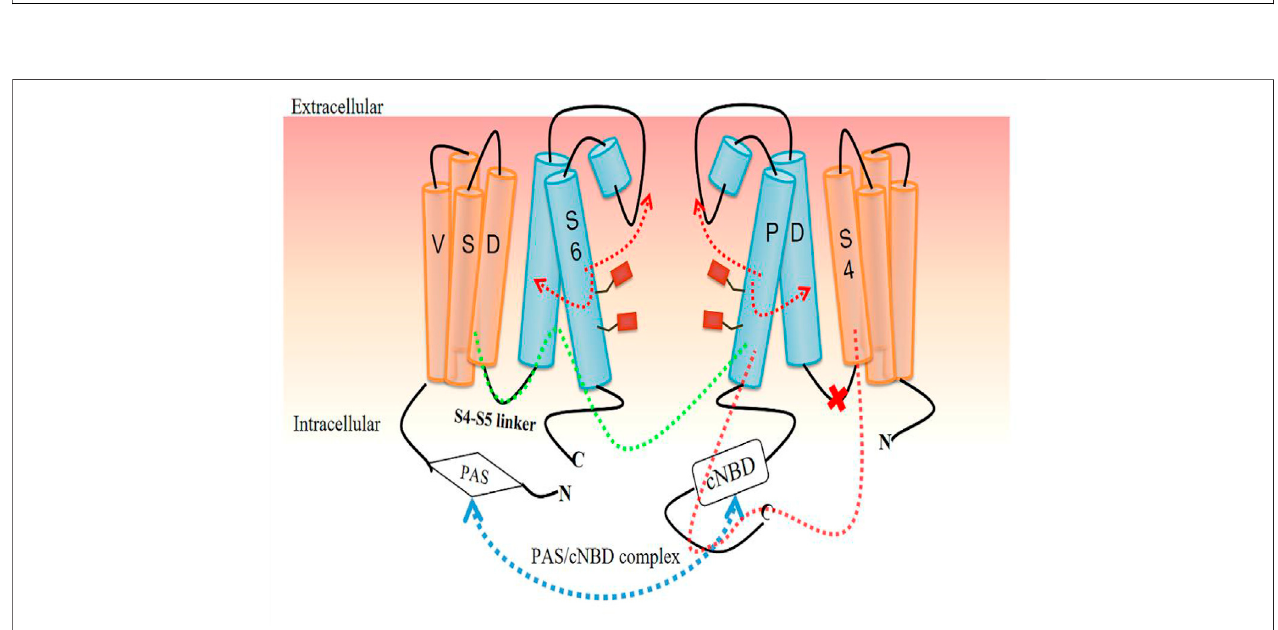
FIGURE 4| Voltage gating regulation model for hERG channel based on the PAS/cNBD complex. The PAS/cNBD complexplays a central role ( blue dotted line ) in this model. Previously, the S4-S5 linker was thought to act as a bridge to transform the conformational changes in the voltage-sensing domain (VSD) into physical movementoftheporedomain (PD)andtheninteract withadjacentsubunitstoregulatetheporegate( greendottedline ).AnewinsightisthattheS4-S5linkercannotact as a bridge ( red cross ), but S4 of VSD directly interacts with S6 of the same subunit, resulting in a change in the state of S6 followed by opening or closing of the channel gate ( red dotted line and arrow